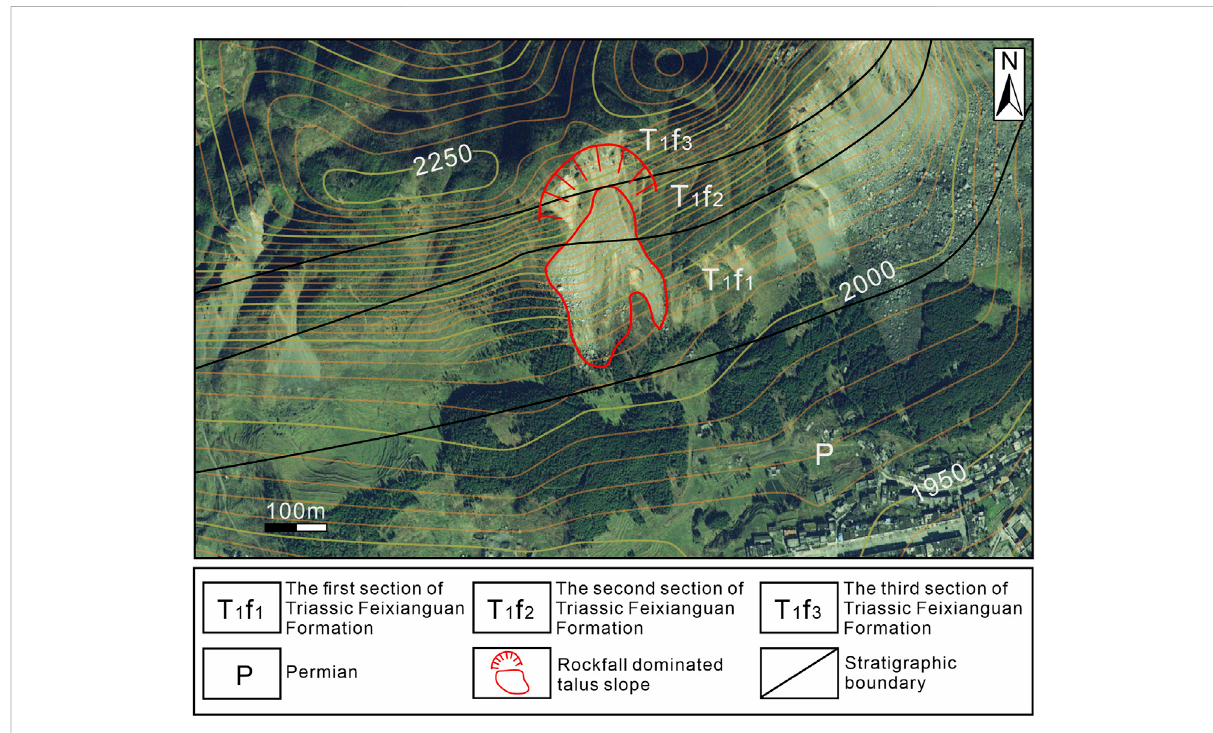
FIGURE 2 Topographic and stratigraphic map of the study site (image source: Google